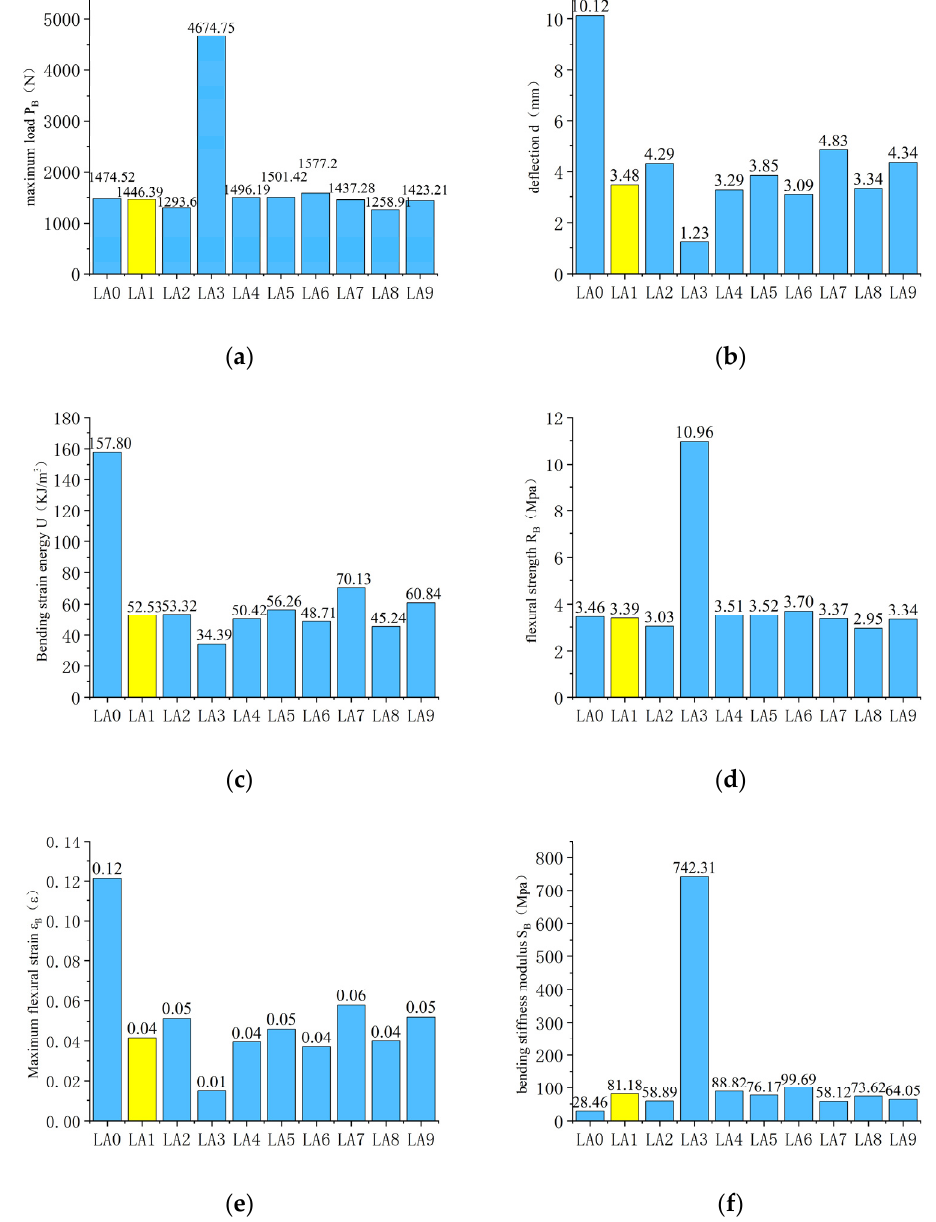
Figure 7. Evaluation index values for bending performance. ( a ) Maximum load P B at specimen failure; ( b ) mid-span deflection d; ( c ) bending strain energy U ; ( d ) flexural tensile strength R B ; ( e ) beam bottom maximum flexural tensile strain ε B . ( f ) bending stiffness modulus S B